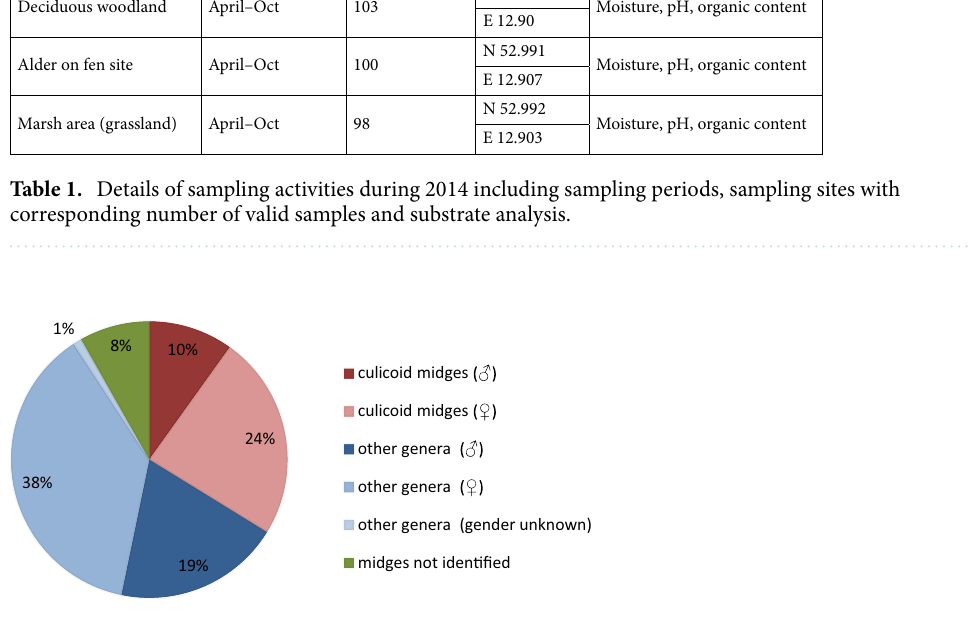
Figure 1. Composition of ceratopogonids sampled in all study